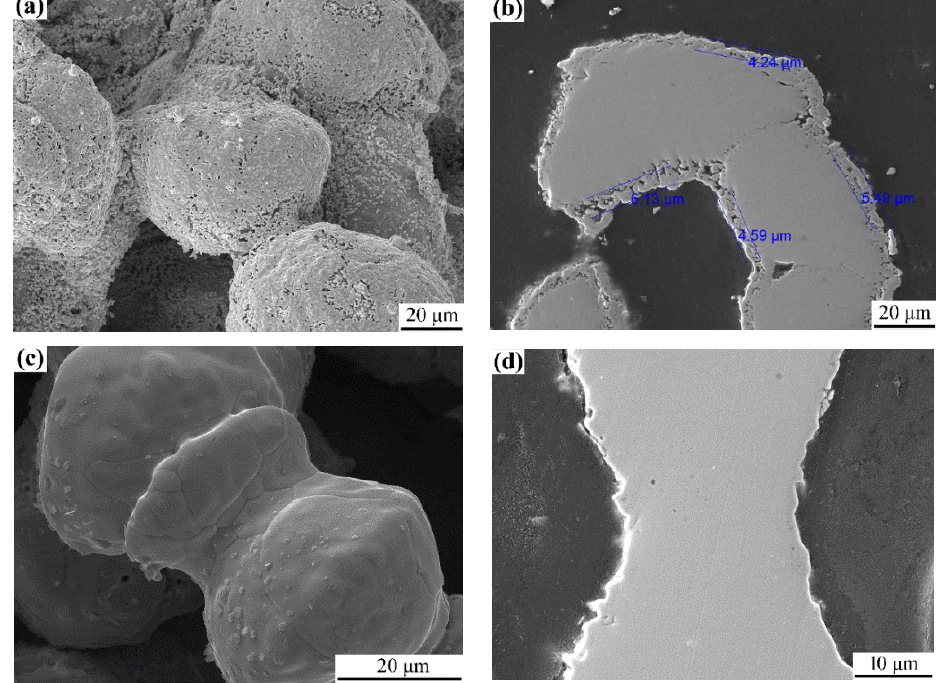
Figure 5. Surface morphology of porous Mo and cross-sectional microstructure of inter-particle bonding neck for sintering times of 2 h ( a , b ) and 6 h ( c , d ), respectively.